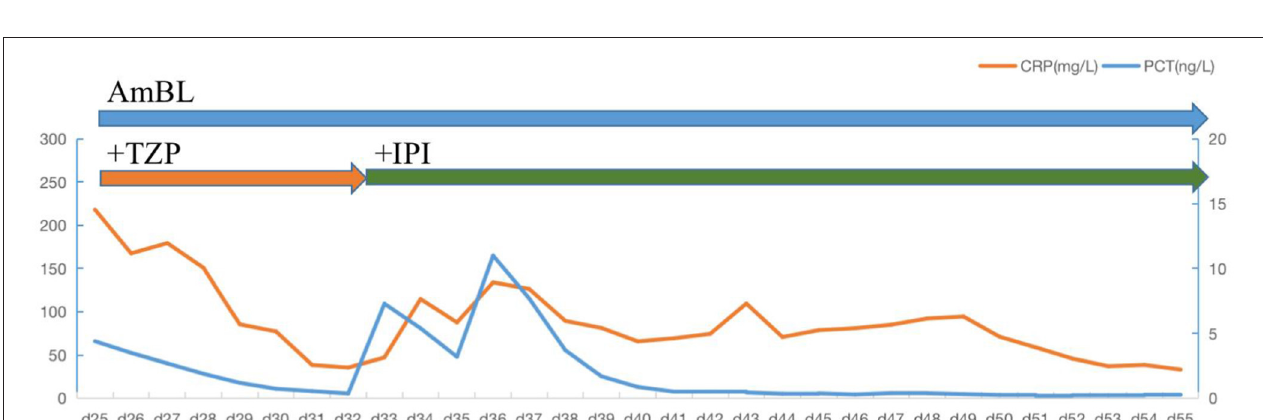
FIGURE 3 | CT imaging for the patient’s lung. (A) On day 25, a CT scan of the lung showed multiple inflammatory lesions (red arrow) and small amount of bilateral pleural effusion in both lungs. (B) After 2 weeks of treatment, a CT scan showed that the lesions were absorbed in the right side of patient’s lung. (C) After 3 weeks of treatment, a CT scan showed that lesions were significantly absorbed in the right side of patient’s lung (red arrow) and smaller amount of bilateral pleural effusion in the side of patient’s lung than that after 2 weeks of treatment.